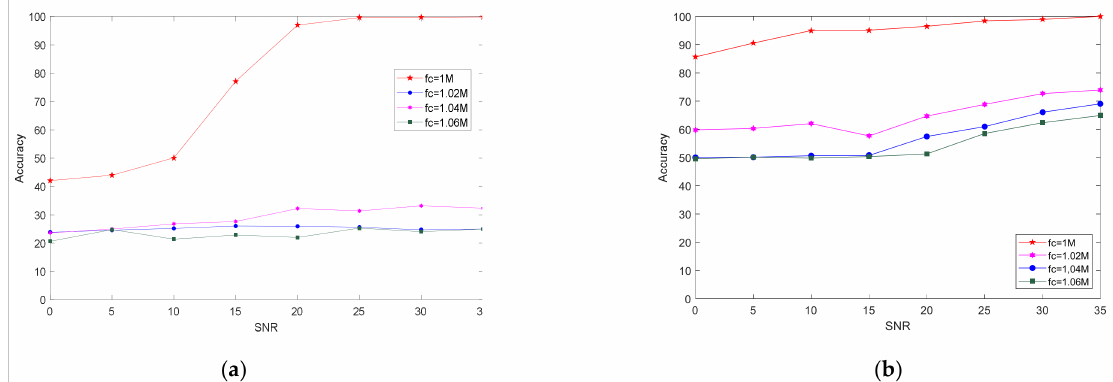
Figure 11. Experimental results when using different carrier-frequency data and ( a ) bispectral method or ( b ) proposed method as the test set.